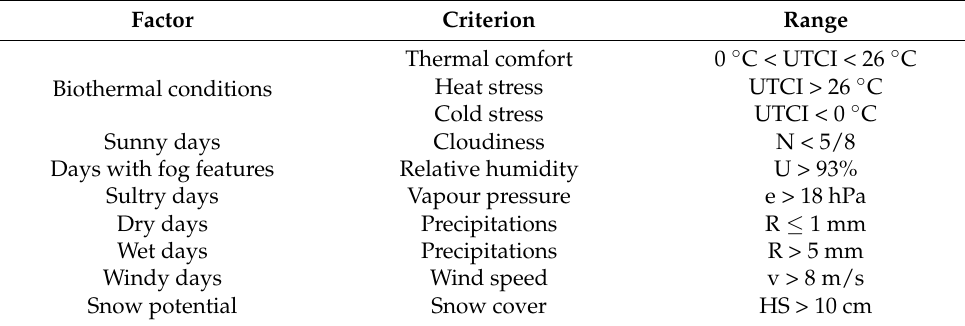
Table 3. Climate Tourism Information Scheme (CTIS) [3;